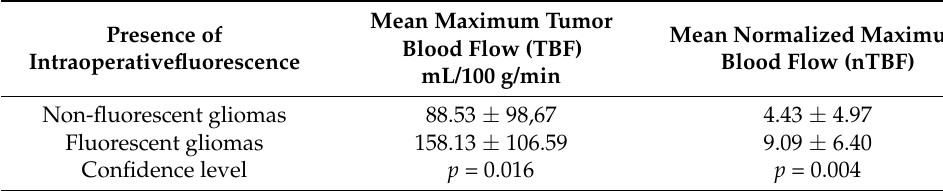
Table 3. Maximum (TBF) and normalized maximum (nTBF) blood flow values in groups of fluores- cent and non-fluorescent gliomas.